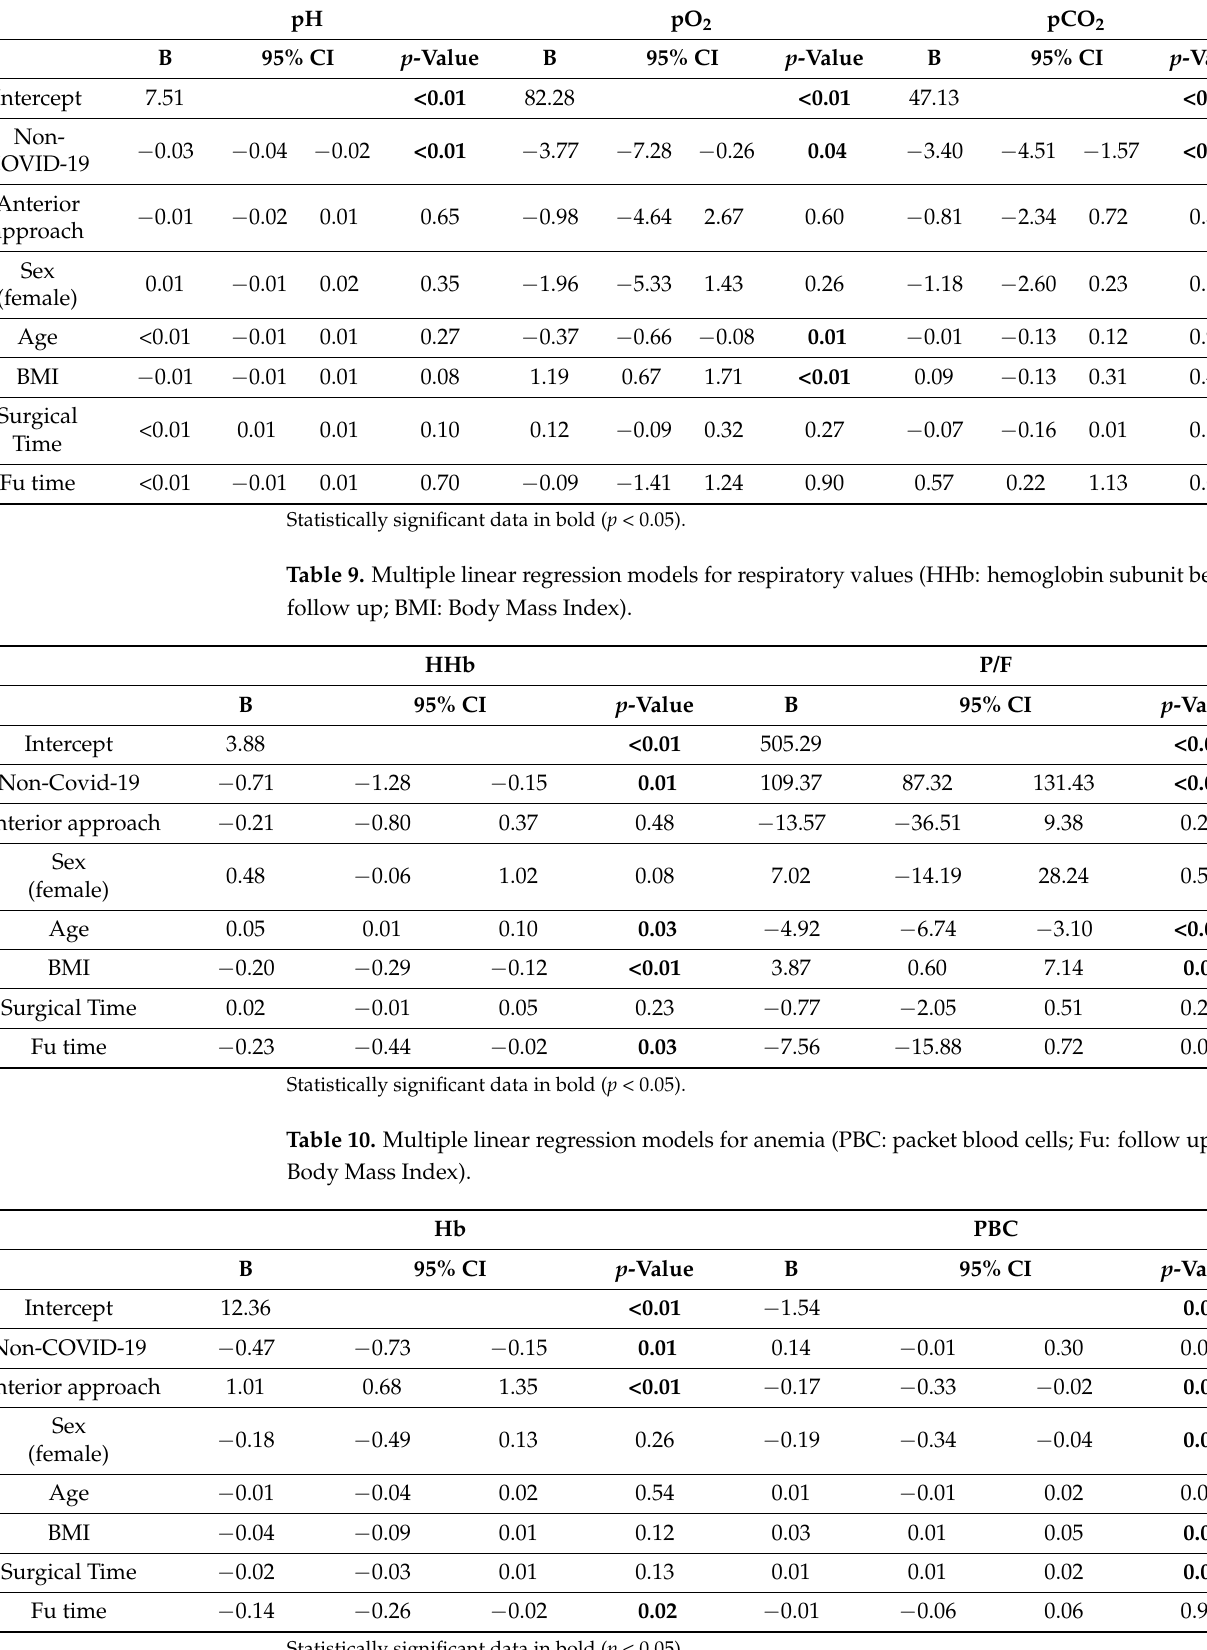
Table 8. Multiple linear regression models for respiratory values (Fu: follow up; BMI: Body Mass Index).